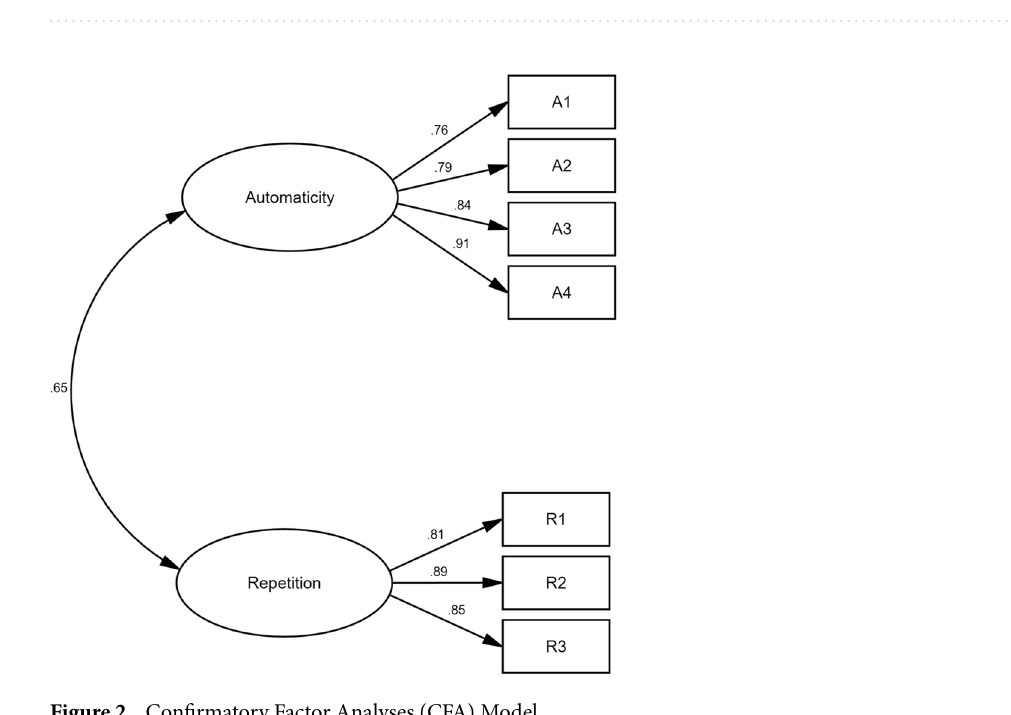
Table 2. Results of Exploratory Factor Analysis (EFA) and Cronbach’s αcoefficient. ***Significant at the 0.001 level.